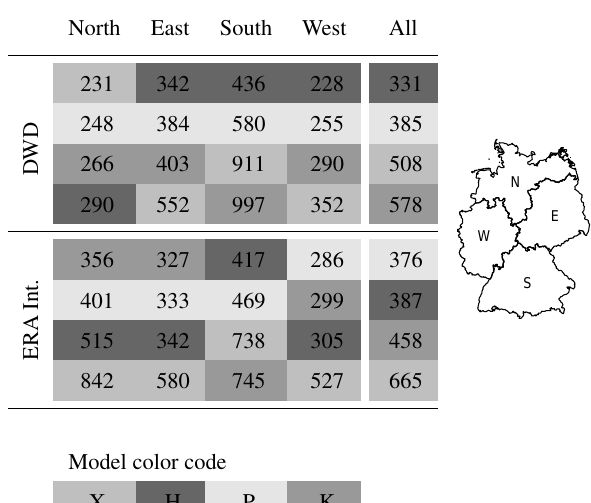
Table 3. Results from a binomial test for prediction accuracy of the different models based on daily loss estimates calculated from DWD wind data. The model of each column is tested against each row of competing models and across loss classes (as defined in Tab. 1). Bold results indicate superiority of the tested model with statistical significance greater than